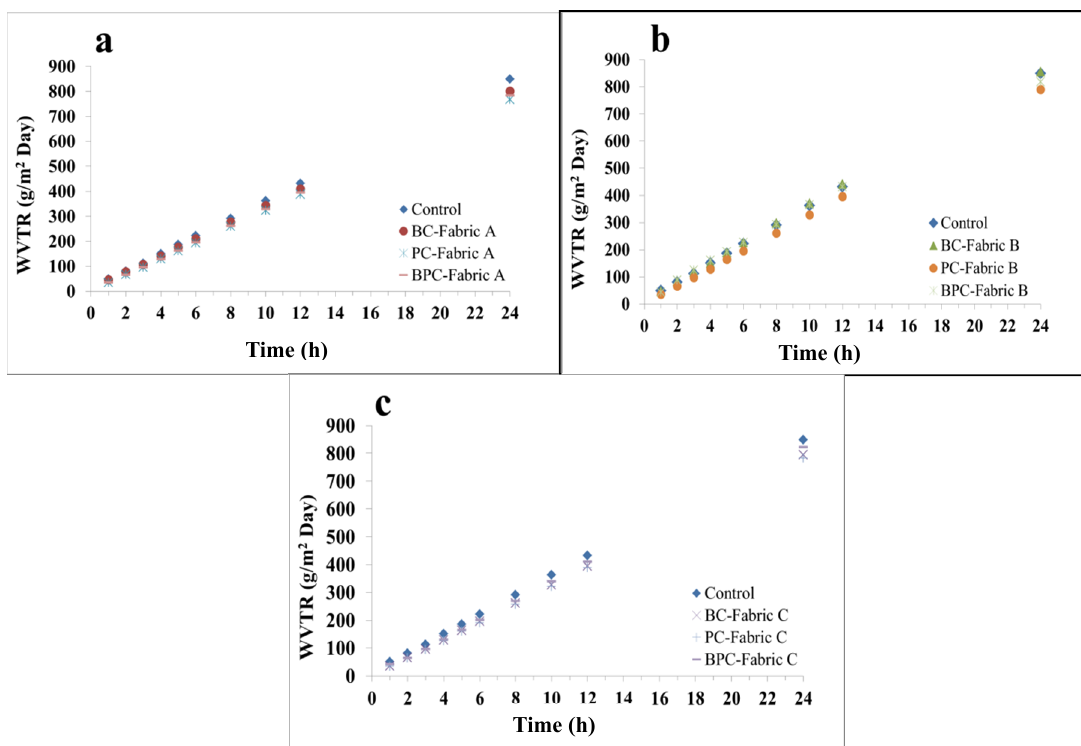
Figure 7. Far ‐ infrared emissivity of elastic warp ‐ knitted fabrics (Fabrics A ( a ), B ( b ) and C ( c )) made by ring ‐ spun complex yarns (BC, PC and BPC).